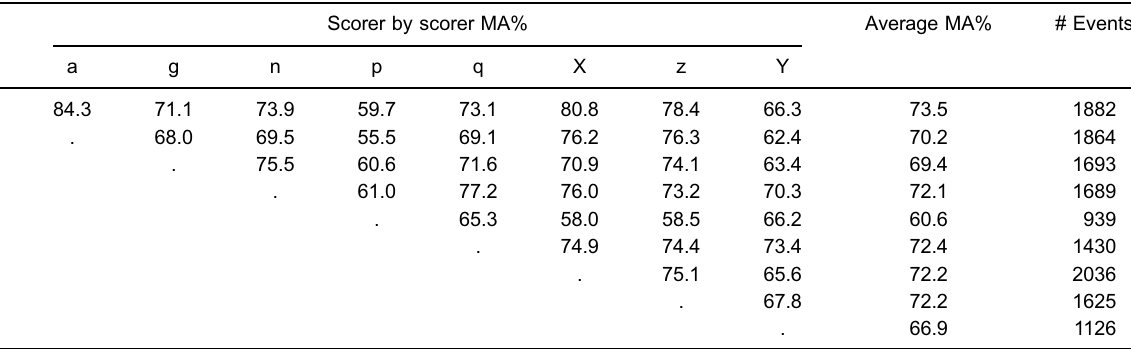
Table 2. Inter-scorers mutual agreement.